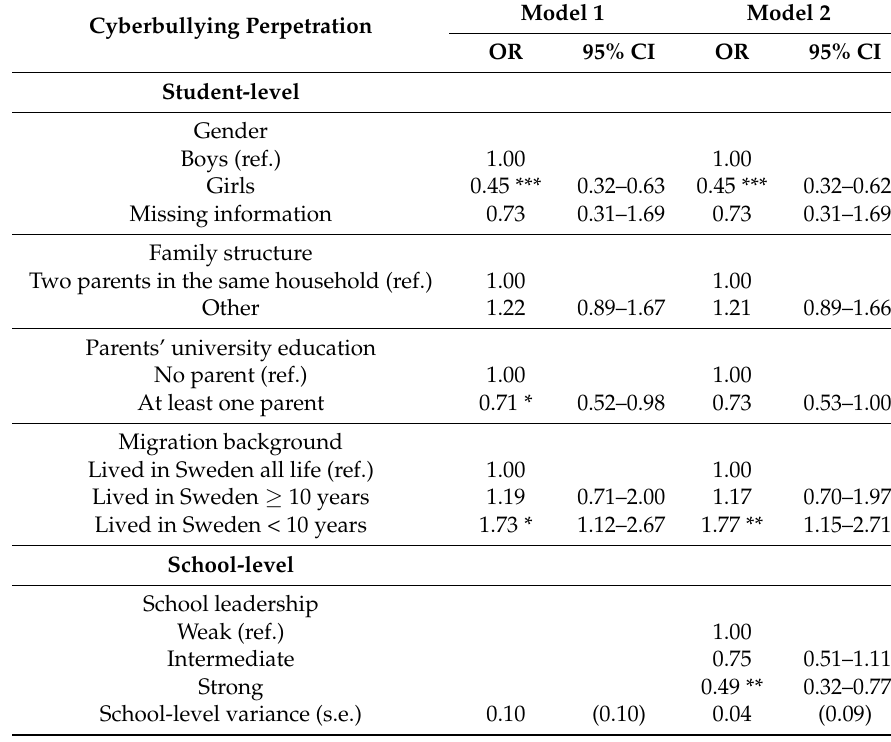
Table 4. Results from two-level binary logistic regression models of cyberbullying perpetration. Odds ratios and 95% confidence intervals. n = 5781 students within 58